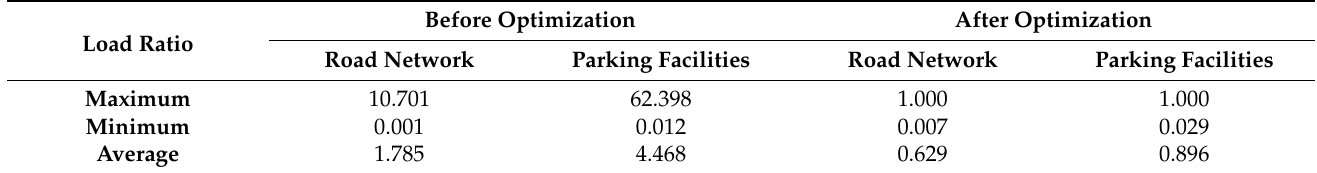
Table 4. Load ratios of traffic facilities before and after